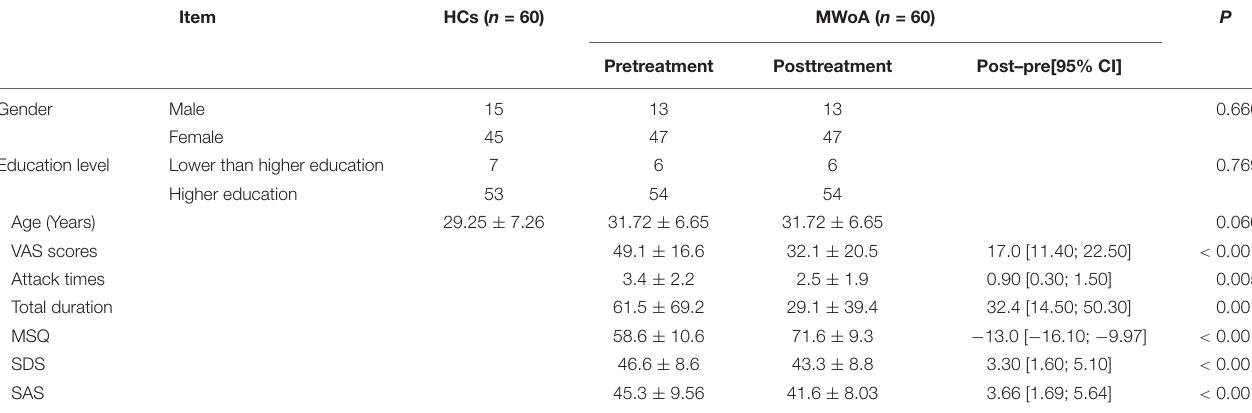
TABLE 1 | Demographic characteristics and clinical outcomes of MWoA and HCs.